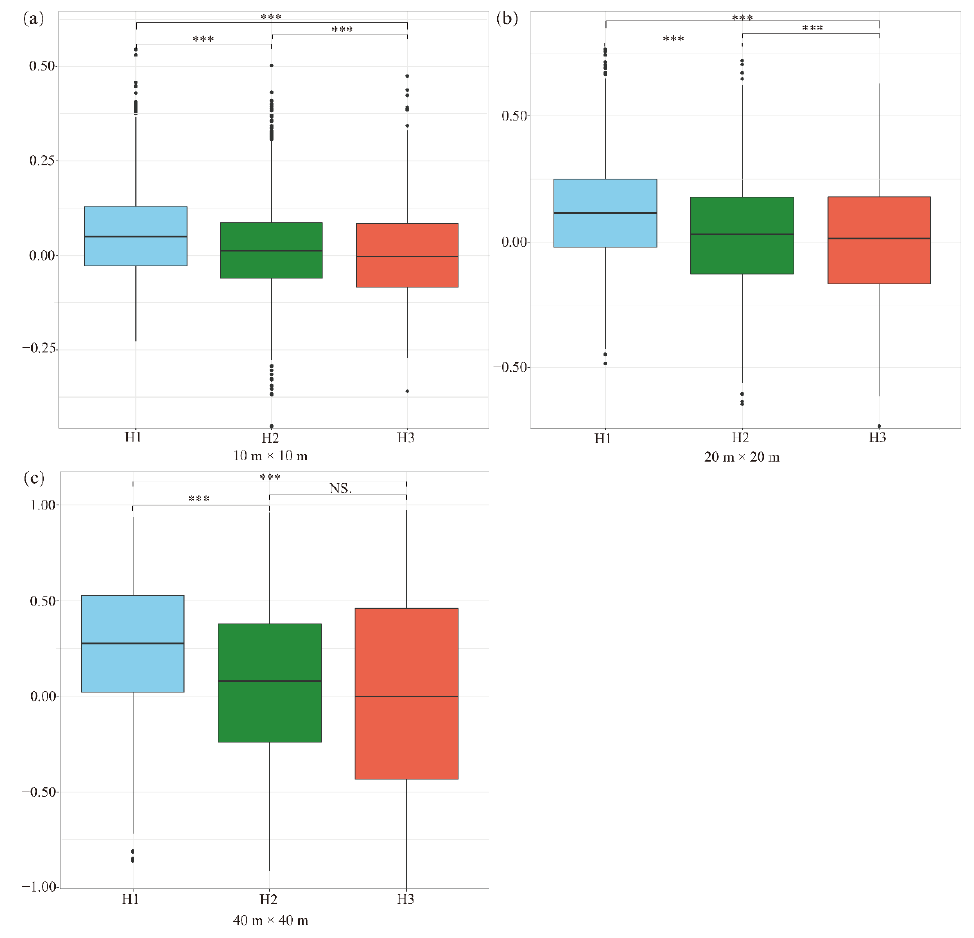
Figure 3. Boxplots of interspecific associations of three habitats at different scales: 10 m × 10 m scale ( a ), 20 m × 20 m scale ( b ), and 40 m × 40 m scale ( c ). Asterisks indicate a significant difference in different habitat types (*** p < 0.001; NS, nonsignificant).